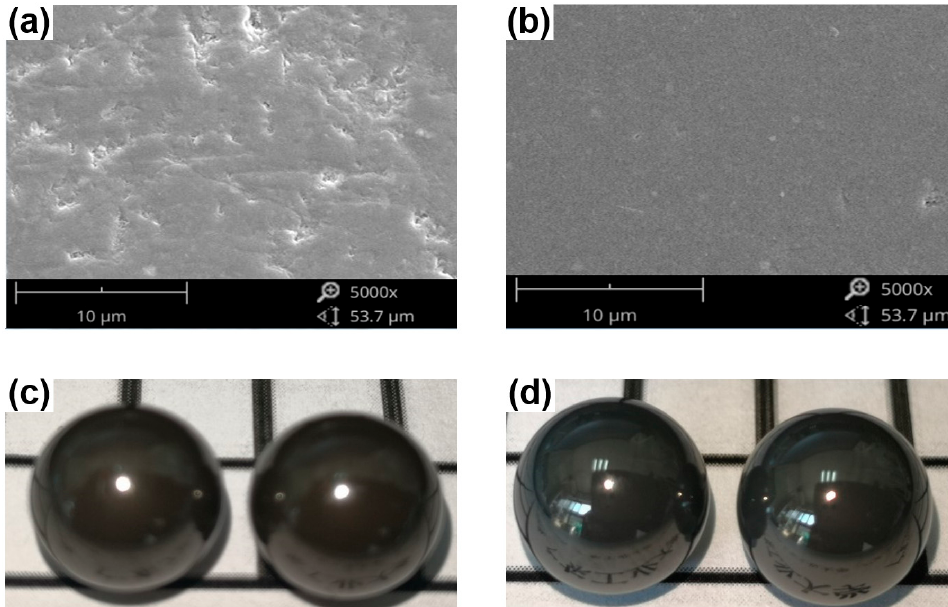
Figure 12. Surface conditions of Si 3 N 4 ceramic balls: ( a ) SEM topography of unfinished surface, ( b ) SEM topography of finished surface, ( c ) optical image of unfinished surface, ( d ) optical image of finished surface. Data obtained from Ref. [62], under an open access CC BY 4.0 license.